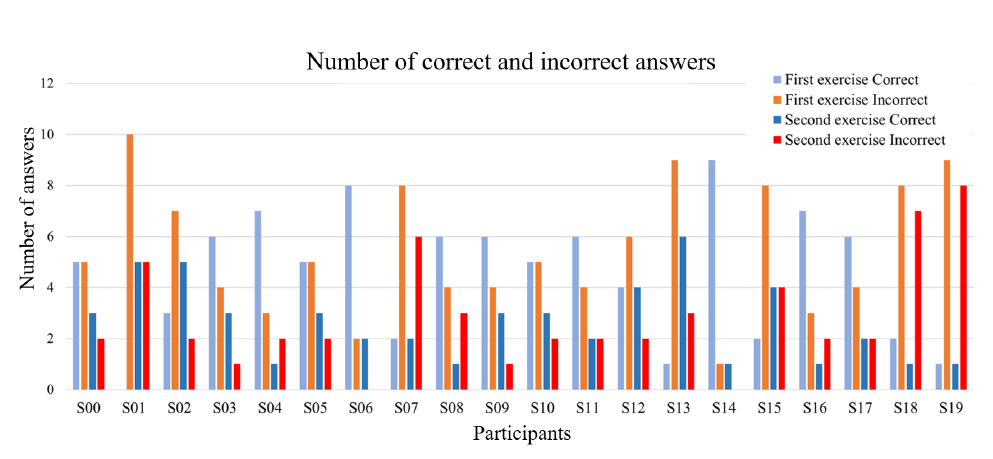
Figure 6. Behavioral results. Number of correct and incorrect answers by each participant in the first and second approaches (following an incorrect answer).